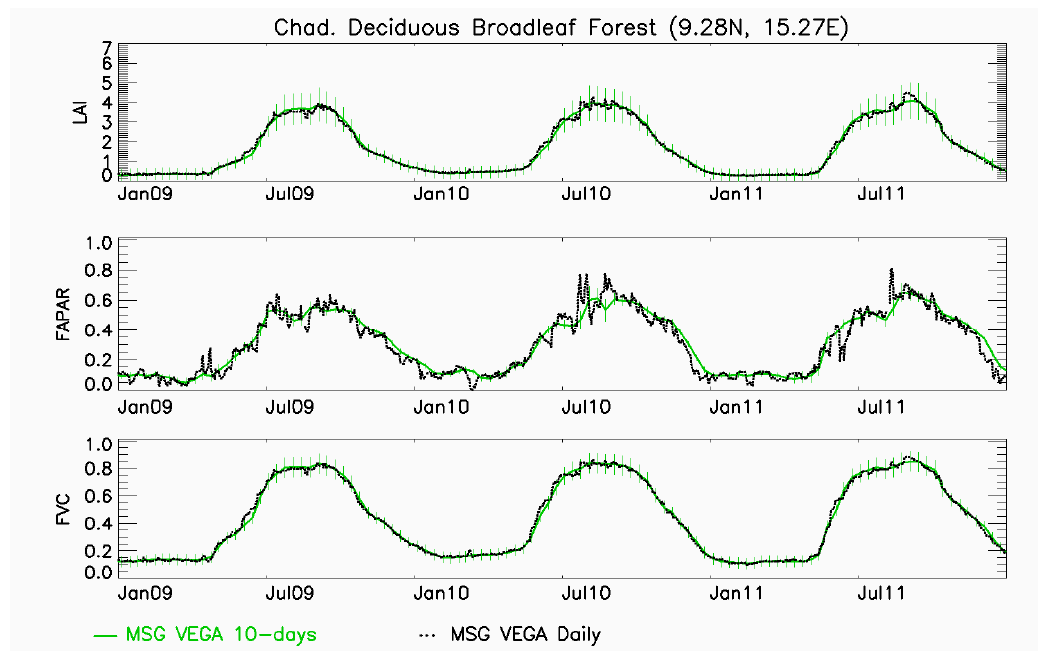
Figure 9. Time series of LAI, FAPAR and FVC daily and 10-days products at a Deciduous Broadleaf Forest site.